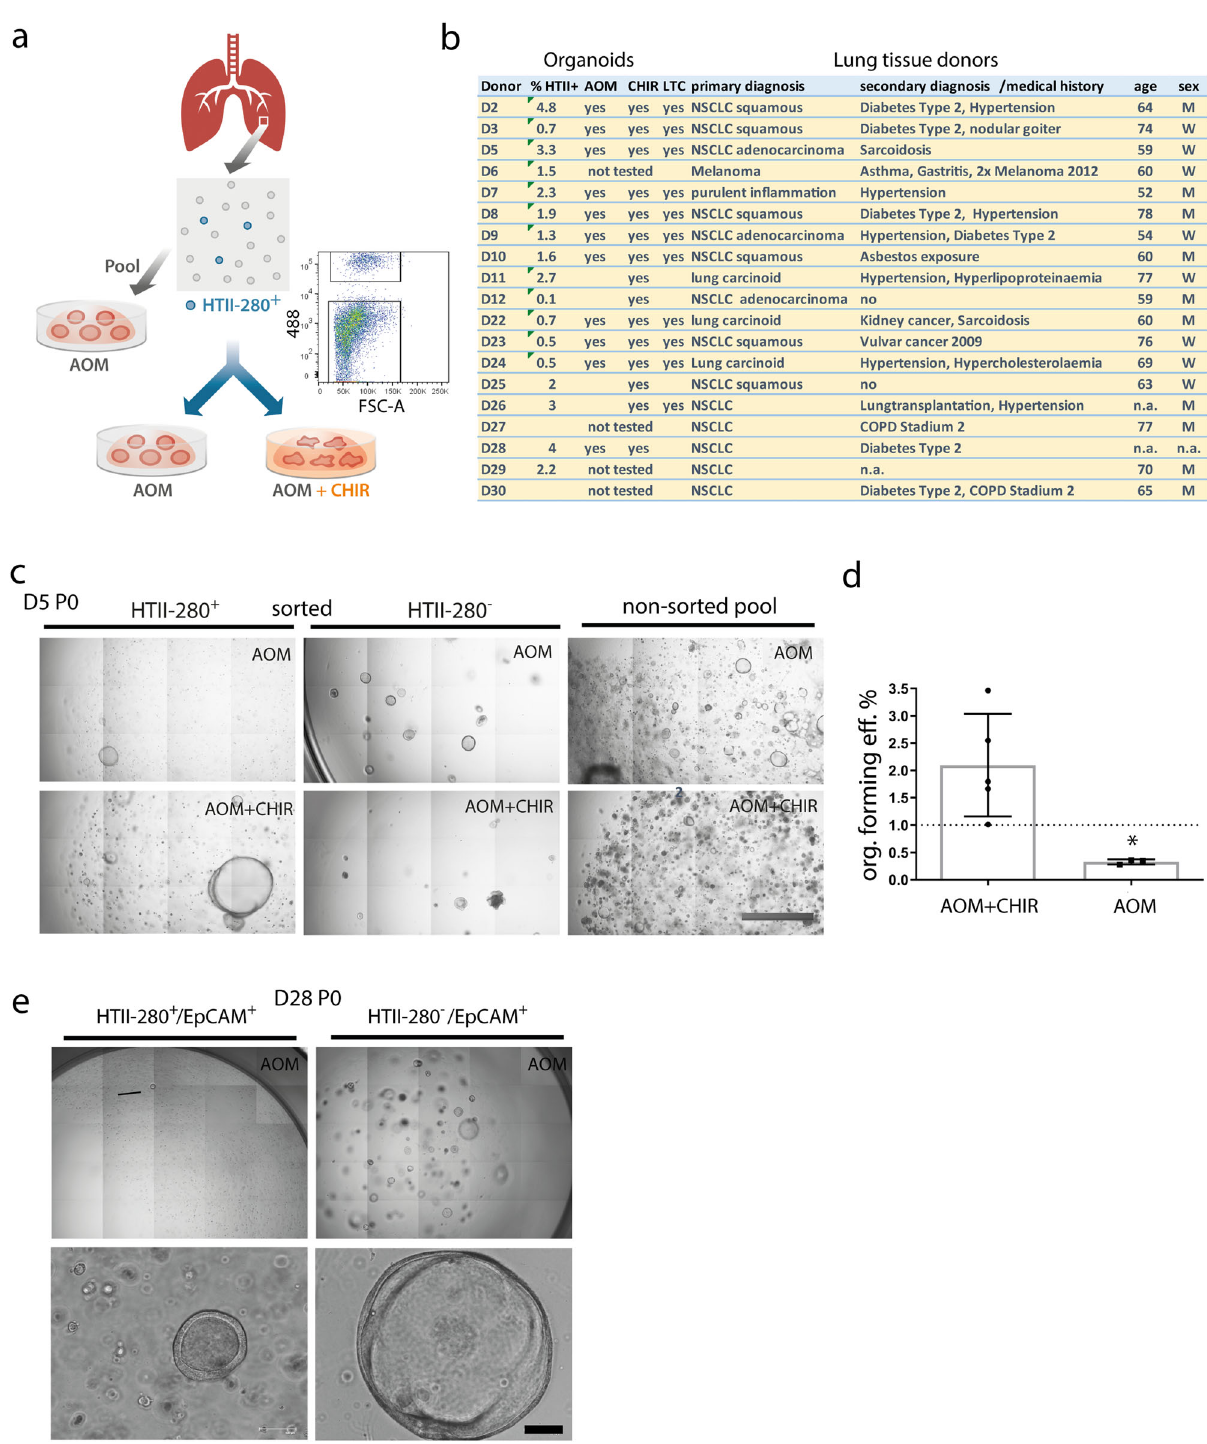
Fig. 2 HTII-280 + progenitors from adult human lung generate in vitro organoids. a Experimental layout of the progenitor isolation and generation of HTII-280 + -derived organoid lines. b Summary of clinical data for donor lung tissue processed to generate organoid lines. LTC- long-term culture, n.a. — not available. c HTII-280 + cells give rise to organoids in AOM and AOM + CHIR medium, while HTII-280 - epithelial progenitors have higher organoid forming ef fi ciency in the AOM medium. Also, non-sorted pool isolates show robust growth in AOM medium. d Quanti fi cation of organoid forming ef fi ciency of HTII-280 + progenitors in AOM + CHIR and AOM medium. n = 5 and n = 3, respectively, where n are independent donor samples. Data represent mean + / – SEM. * p = 0.02 calculated by a two-tailed student t -test. e HTII-280 - /EpCAM + progenitors grow better in AOM medium compared to HTII-280 + / EpCAM + cells. The image is representative of three independent sort experiments. Scale bar: 100 µ m.